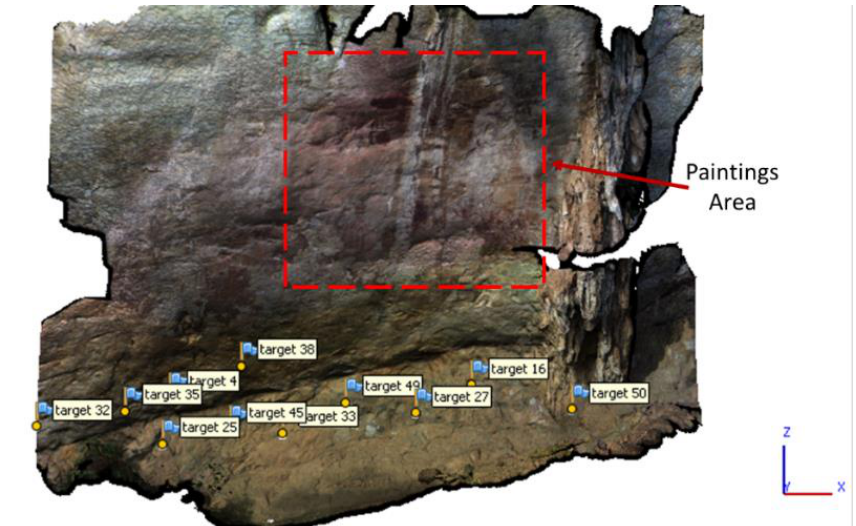
Figure 4. Location of painting panel and control